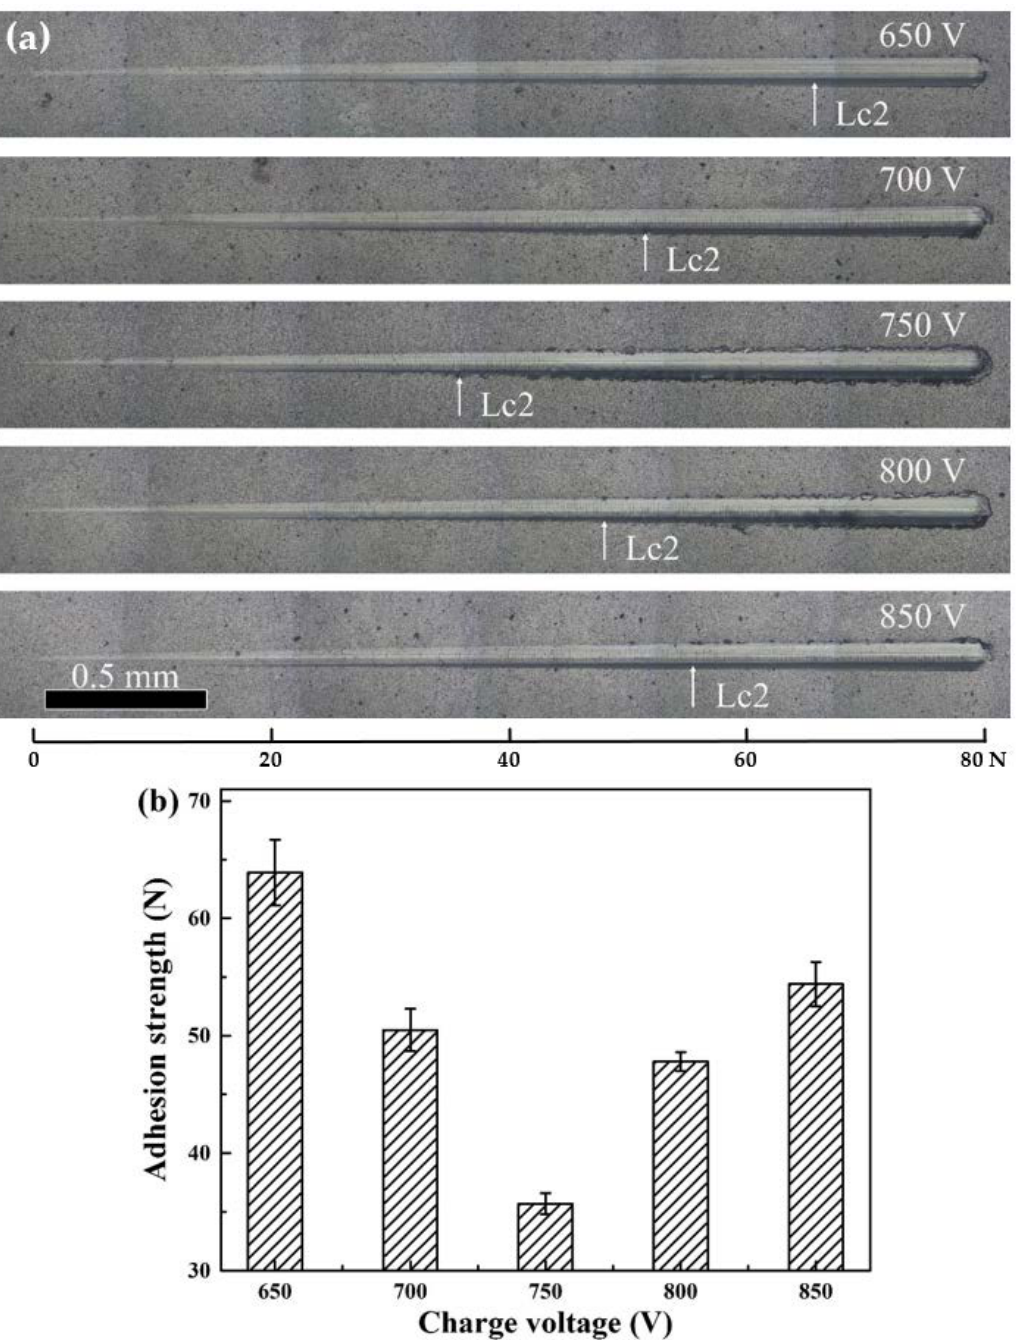
Figure 9. Scratch tracks ( a ) and adhesion strength ( b ) of the coatings at various charge voltages.